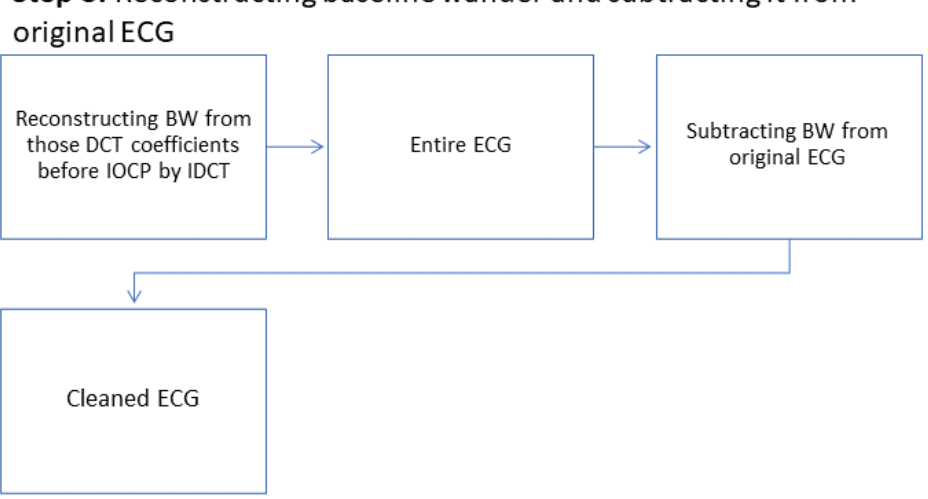
Figure 2. Block diagram of the Dual-Adaptive Scheme.